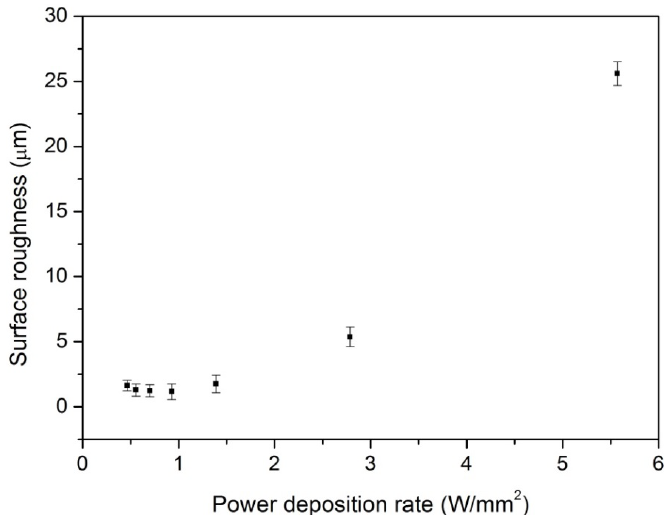
Figure 5. Effect of PDR on surface roughness at a fixed laser fluence of 26.39 J/cm 2